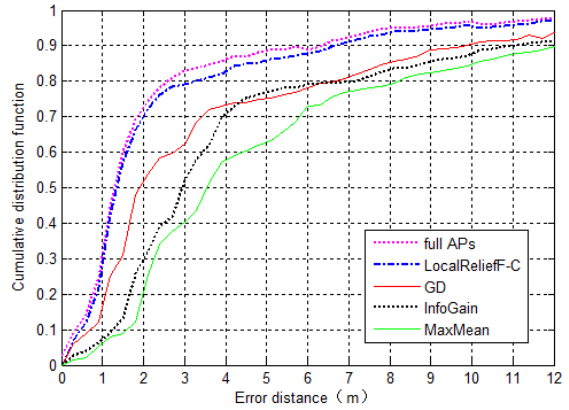
Figure 14. Precision comparison of AP selection methods. GD, group-discrimination.